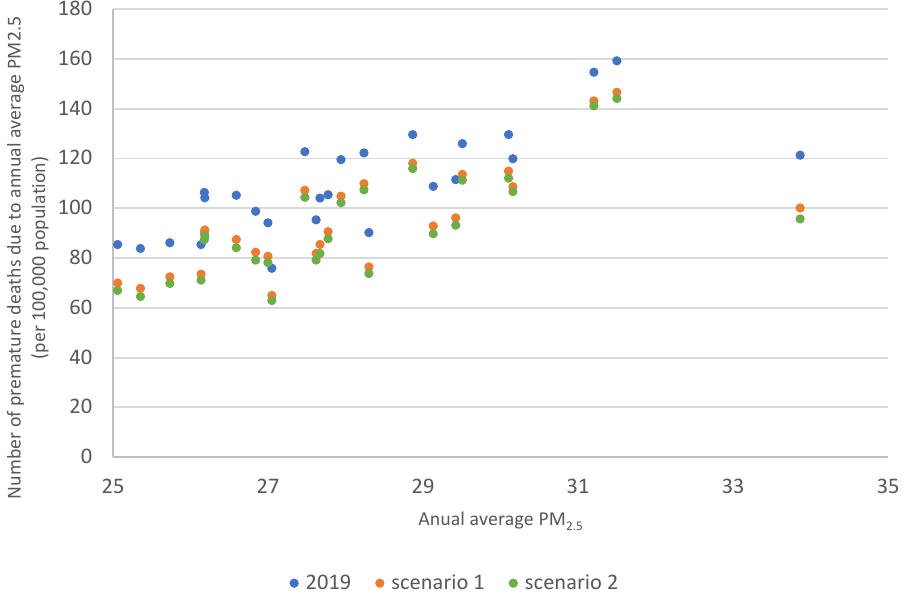
Figure 11. Number of premature deaths per 100,000 inhabitants due to PM2.5 concentrations above 25 µg/m 3 in counties in Poland in 2019 (blue points) and scenario 1 (orange points) and scenario 2 (green points).